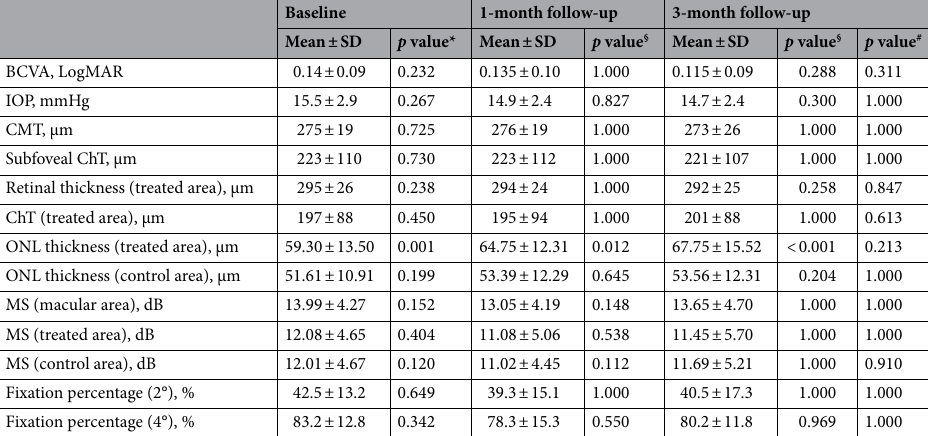
Table 2. Comparisons of anatomical and functional variables between baseline, 1-month follow-up and 3 month follow-up after the treatment. SD standard deviation, BCVA best-corrected visual acuity, IOP intraocular pressure, CMT central macular thickness, ChT choroidal thickness, ONL outer nuclear layer, MS retinal sensitivity. *Analysis of Variance (ANOVA) for paired samples. § Comparison with baseline using ANOVA for paired samples with Bonferroni post-hoc analysis. # Comparison with 1-month follow-up using ANOVA for paired samples with Bonferroni post-hoc anaysis.